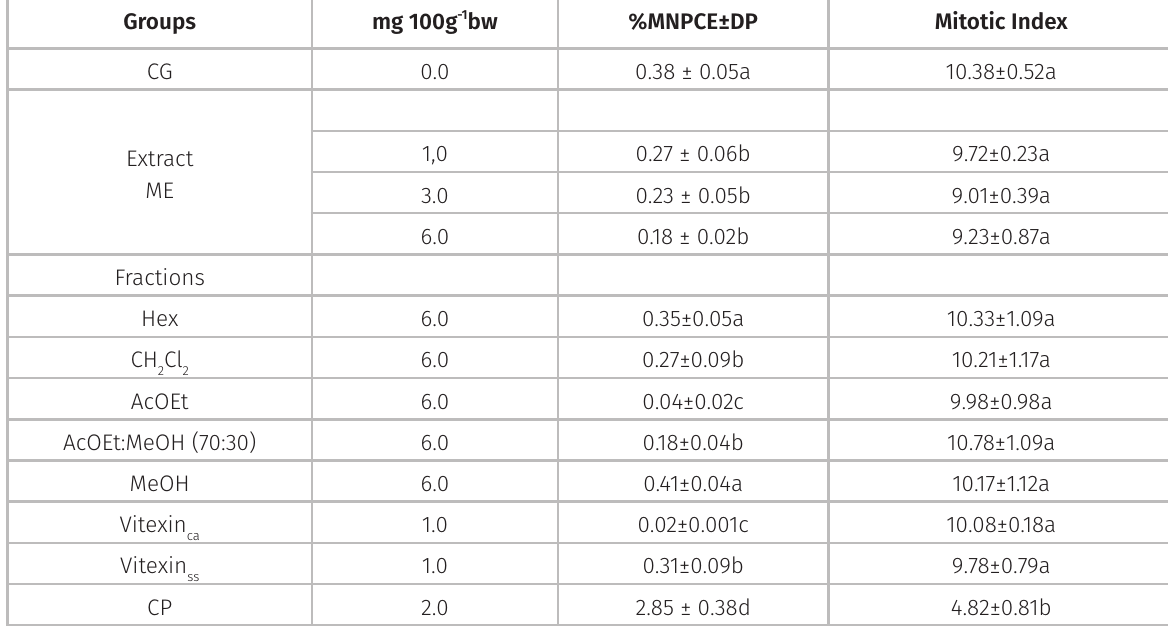
Table I. Mitotic Index and Micronucleated polychromatic erythrocyte (MNPCE) frequency in Swiss albino mice (n=5) treated with different concentrations of methanolic extract (ME) (1, 3 and 6 mg 100g -1 bw) and fractions Cl , Ethyl Acetate = AcOEt, Methanol = MeOH) (6.0 mg g -1 bw), vitexin isolated (N-Hexane=Hex, Dichloromethane = CH 2 2 ) (1.0 mg g -1 bw), standard sample vitexin (Vitexin ) (1.0 mg g -1 bw), control group from C. antisyphiliticus (Vitexin ca ss (CG) and group (CP) treated with Cyclophosphamide® (2mg 100g -1 bw). 2000 Polychromatic Erythrocytes (PCE) per mouse.